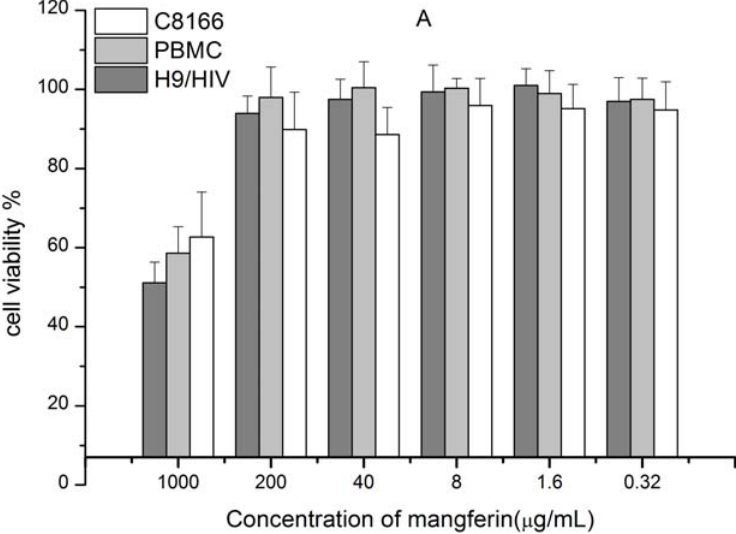
IIIB and HIV-1 IIIB RF infected MT-4 cells ( C IIIB